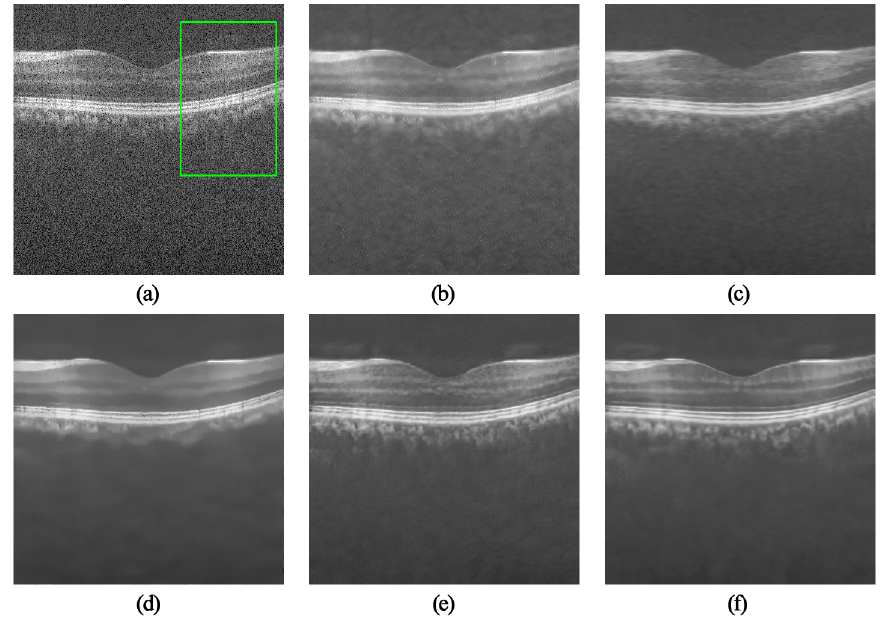
Figure 5. Comparison of denoising OCT-26 image in the real dataset: ( a ) original noisy image (450 × 450), ( b ) image after TNode speckle reduction, ( c ) image after SBSDI speckle reduction, ( d ) image after PNLM speckle reduction, ( e ) image after DIP speckle reduction, ( f ) image after NLM-DIP speckle reduction.